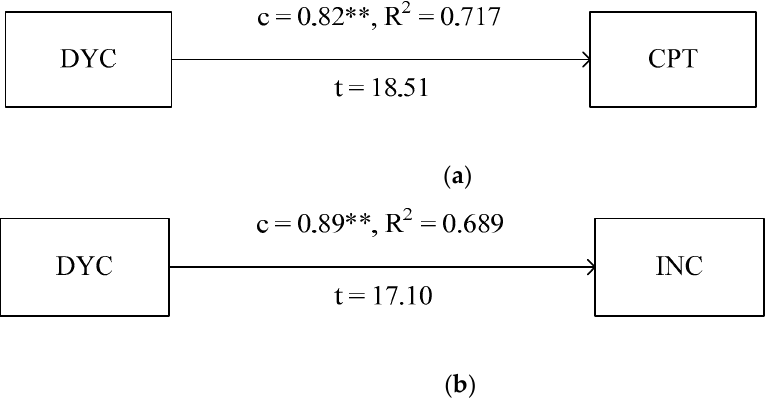
Figure 3. ( a ) Influence of the independent variable (DYC) on the mediator (CPT). ( b ) Influence of the independent variable (DYC) on the mediator (INC). Note: ∗∗ p < 0.001.